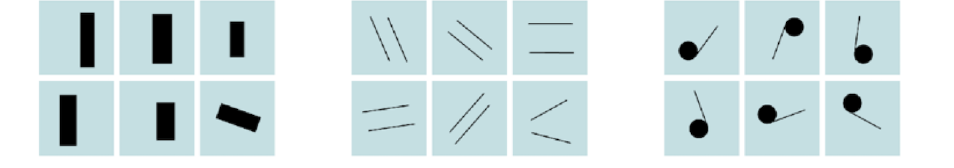
Fig 1. Sample images from the visual form analysis